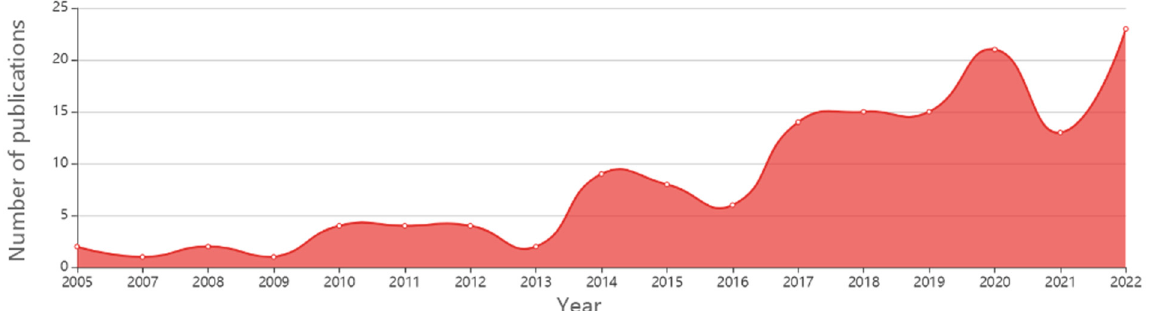
Figure 1. A diagram of worldwide publications on PRP use in foot and ankle, giving the number of articles per year.